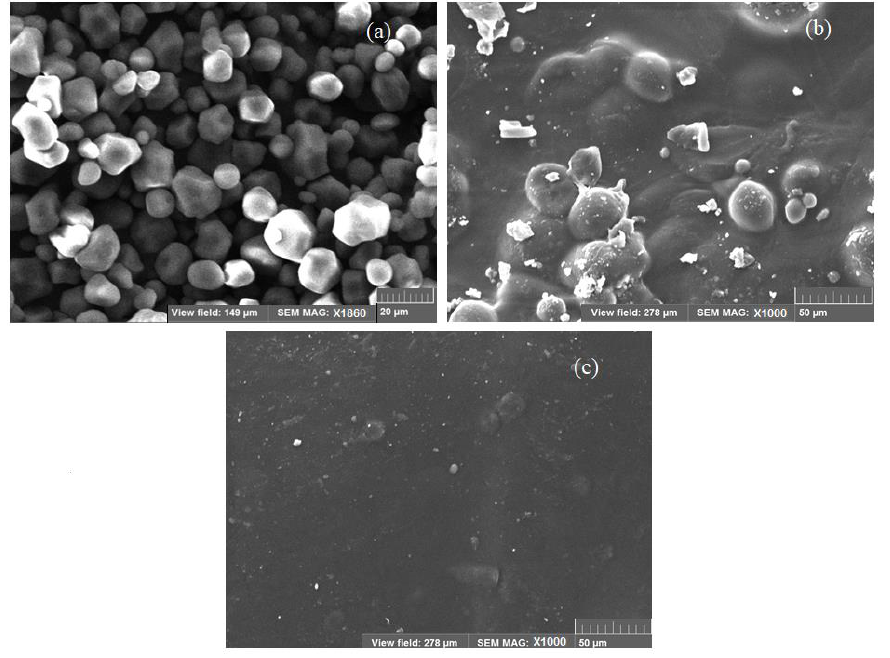
Fig. 2. SEM images of the: (a) native corn starch before processing, (b) TPS without filler, (c) TPS with treated filler.